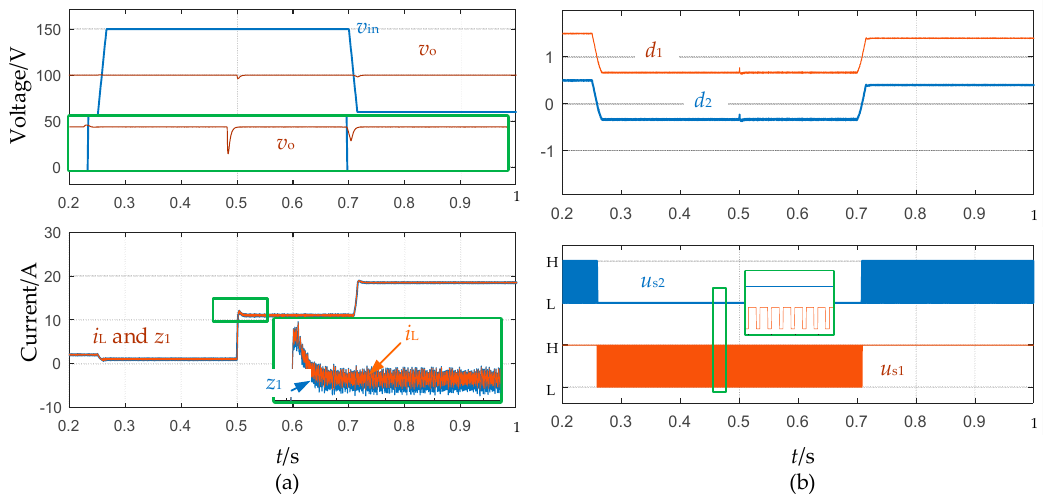
Figure 6. The simulation results: ( a ) Input/output voltage and current and ( b ) duty cycles and driving signals.